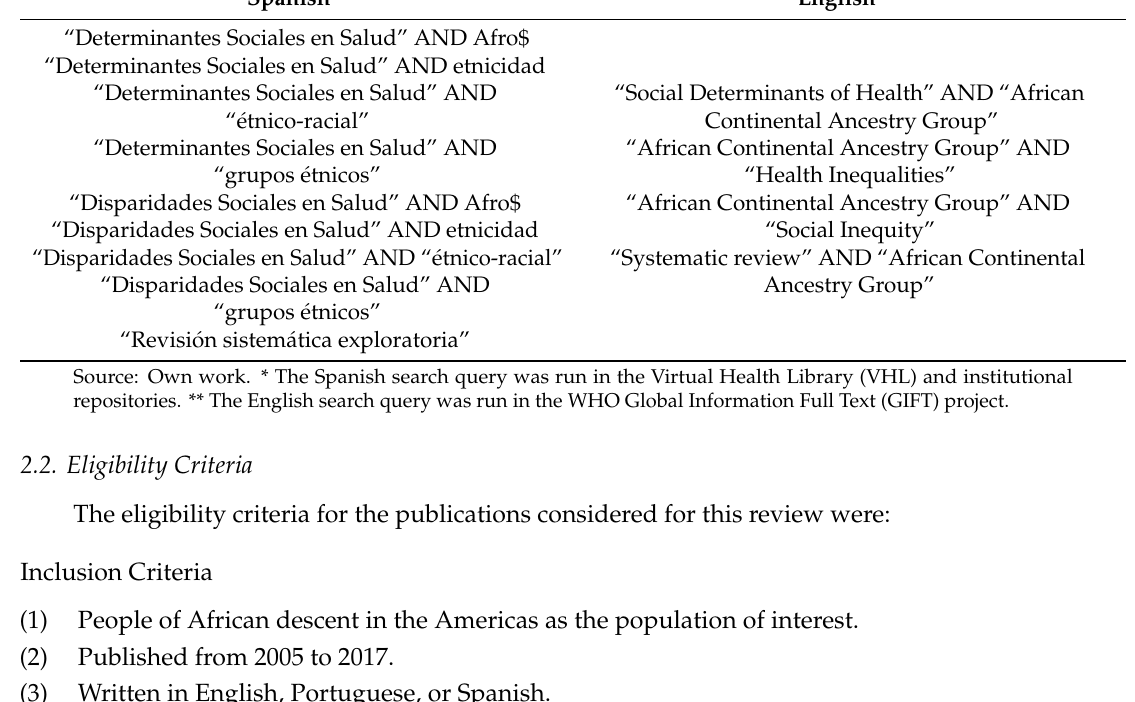
Table1. Descriptoresen Cienciasde la Salud(DeCS) andMedical SubjectHeadings (MeSHs) descriptors. Spanish